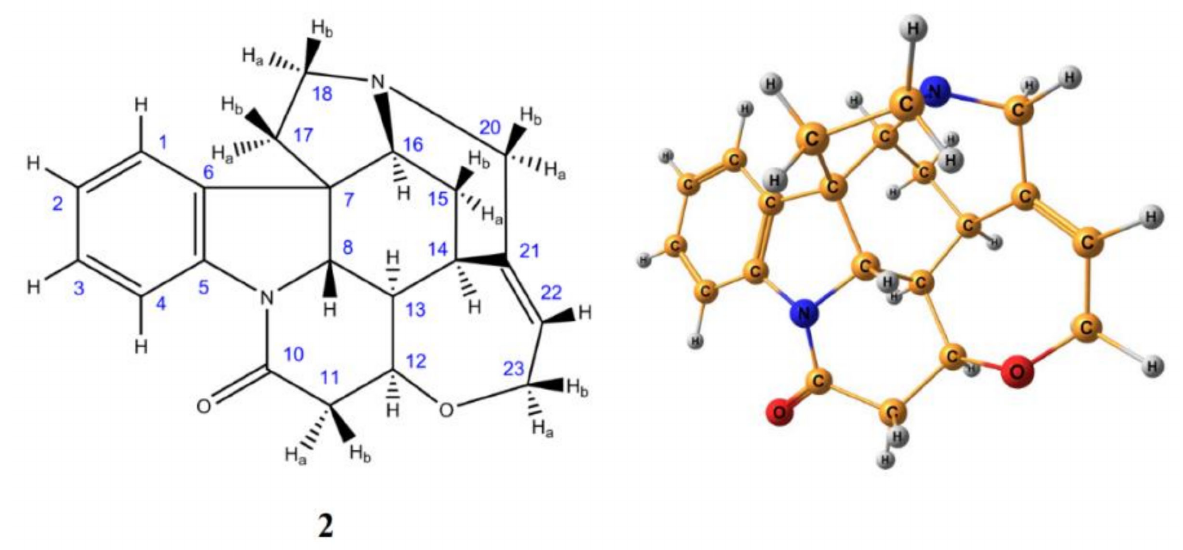
Figure 4. Enumeration of atoms ( left ) and stereochemical structure ( right ) of strychnine. Element colors are as follows: protons—gray, carbons—dark yellow, nitrogens—blue, oxygen—red. Reproduced from Semenov and Krivdin [67] with the permission of John Wiley and